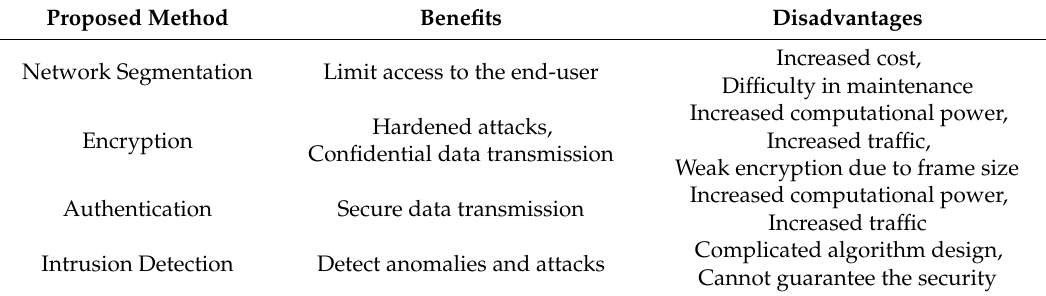
Table 2. Methods to secure the CAN